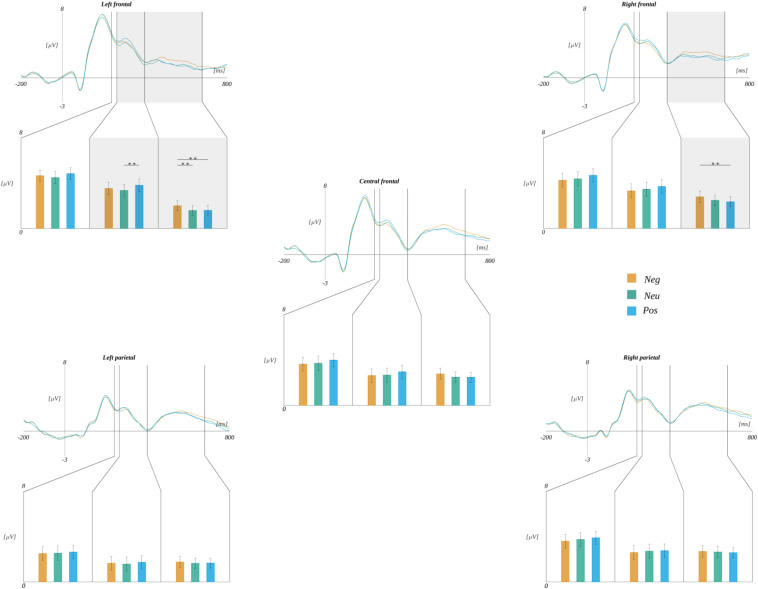
Effects of interaction between regions of interest and valence. In each panel, the upper plot shows grand average ERP traces for each level of valence, lower bar plot displays the average amplitude within each time-window for each level of subjective significance. Error bars mark SEM. Horizontal lines with asterisks mark significant differences (**p < 0.01). Time-windows with significant effects are marked with gray shadings.